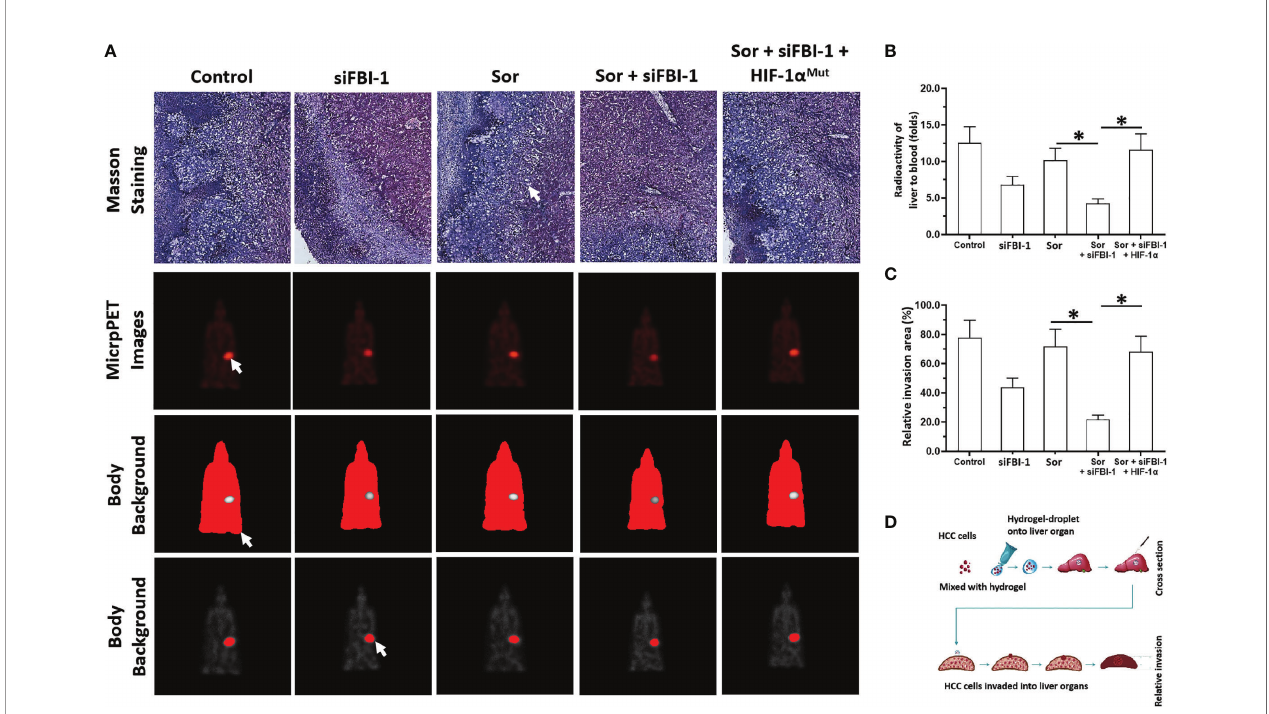
FIGURE 7 | siFBI-1 enhanced the resistance of MHCC97-H cells to Sorafenib in a nude mice model. The MHCC97-H cells were transfected with vectors and injected into the nude mice to form the intrahepatic invasion models. The mice received the oral administration of 0.5 mg/kg Sorafenib. The results are shown as Masson staining (A) micro-PET images (A) , and the quantitative results of micro-PET images (A, B) or Masson staining images (C) . The fl ow chart/model diagram of the intrahepatic invasion model is shown as Panel (D) . The white arrow indicated the intrahepatic lesions via Masson staining (A) , the images of the intrahepatic